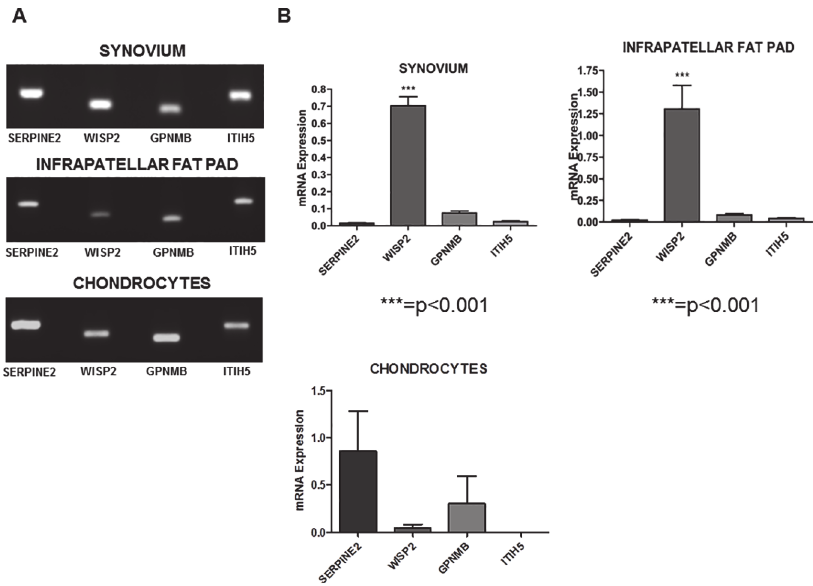
Fig 1. SERPINE2, WISP2, GPNMB and ITIH5 expression evaluated by real-time reverse transcription PCR (qRT-PCR) in synovia, IPFP and chondrocytes obtained from OA patients. A. Amplicons were electrophoresed on 2% agarose gel and stained with ethidium bromide. B. Determination of the basal mRNA expression of SERPINE2, WISP2, GPNMB and ITIH5 in synovial tissues, IPFP and chondrocytes of 30 OA patients. The results were expressed using the ΔΔ C t data analysis method. Statistical analysis was performed using One-way ANOVA followed by Newman-Keuls Multiple Comparison Test. P value *** = p < 0.001 WISP2 vs SERPINE2; GPNMN;